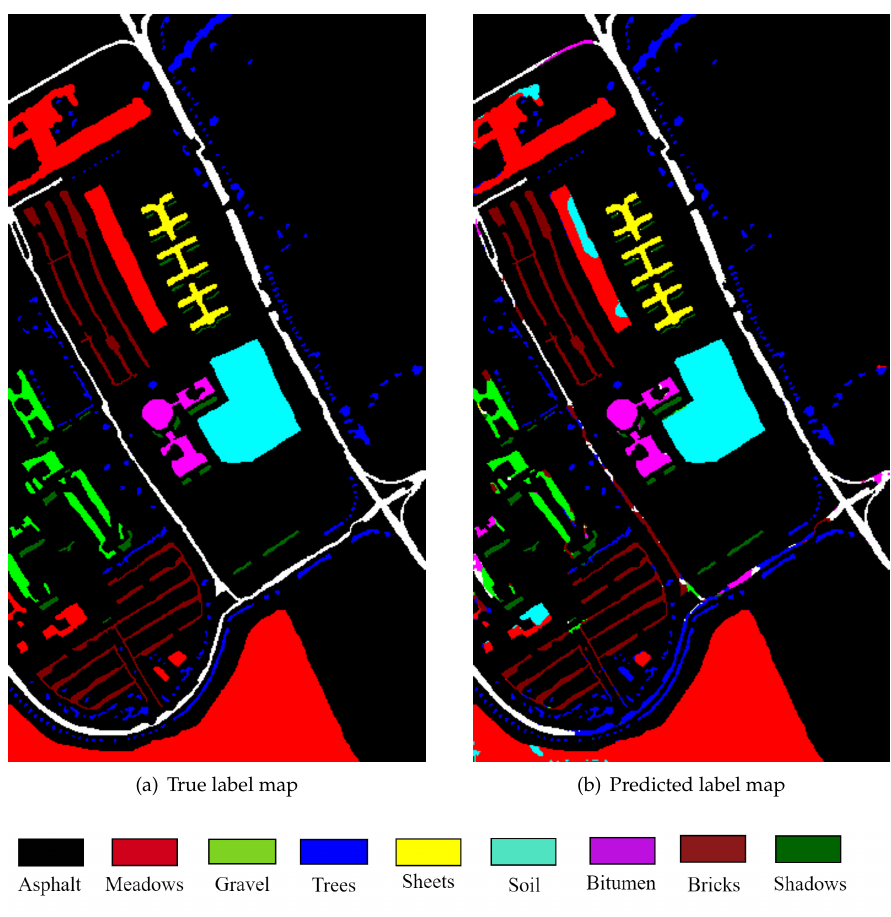
Figure 12. Classification Pavia image by 2D-CNN